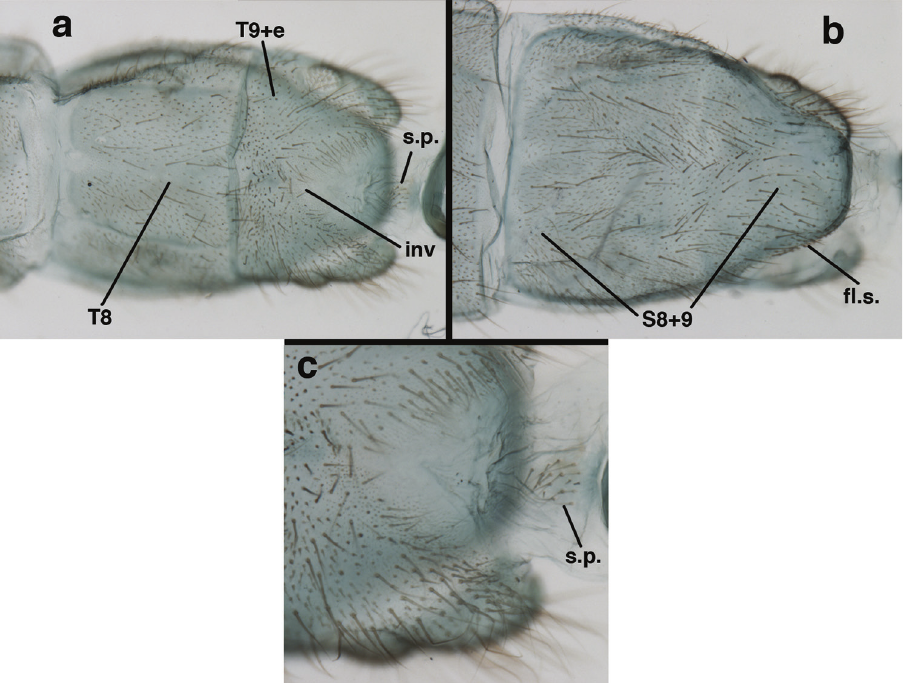
Figure 14. Ungla banksi Tauber, new replacement name: Male abdomen, ( a ) terminal segments, dorsal ( b ) terminal segments, ventral ( c ) tip of tergite 9 + ectoproct, dorsal. fl.s. flanged setae inv dorsal invagi- nation of T9+ectoproct s.p. setose subanal plate S8+9 fused eighth and ninth sternites T8 eighth tergite T9+e fused ninth tergite and ectoproct (Bolivia, Rio Zongo, holotype, MCZ).